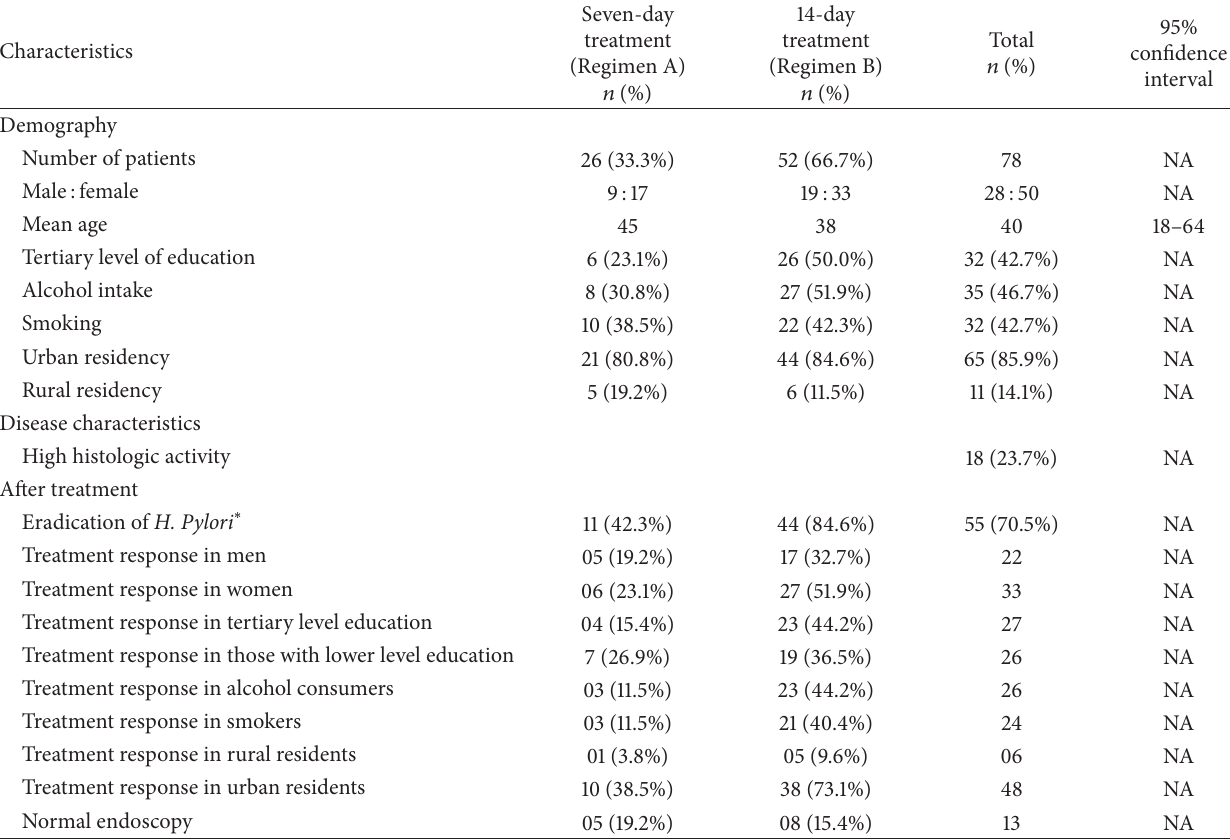
Table 1: Comparison of demography, disease characteristics, and outcome among Regimen A and Regimen B.